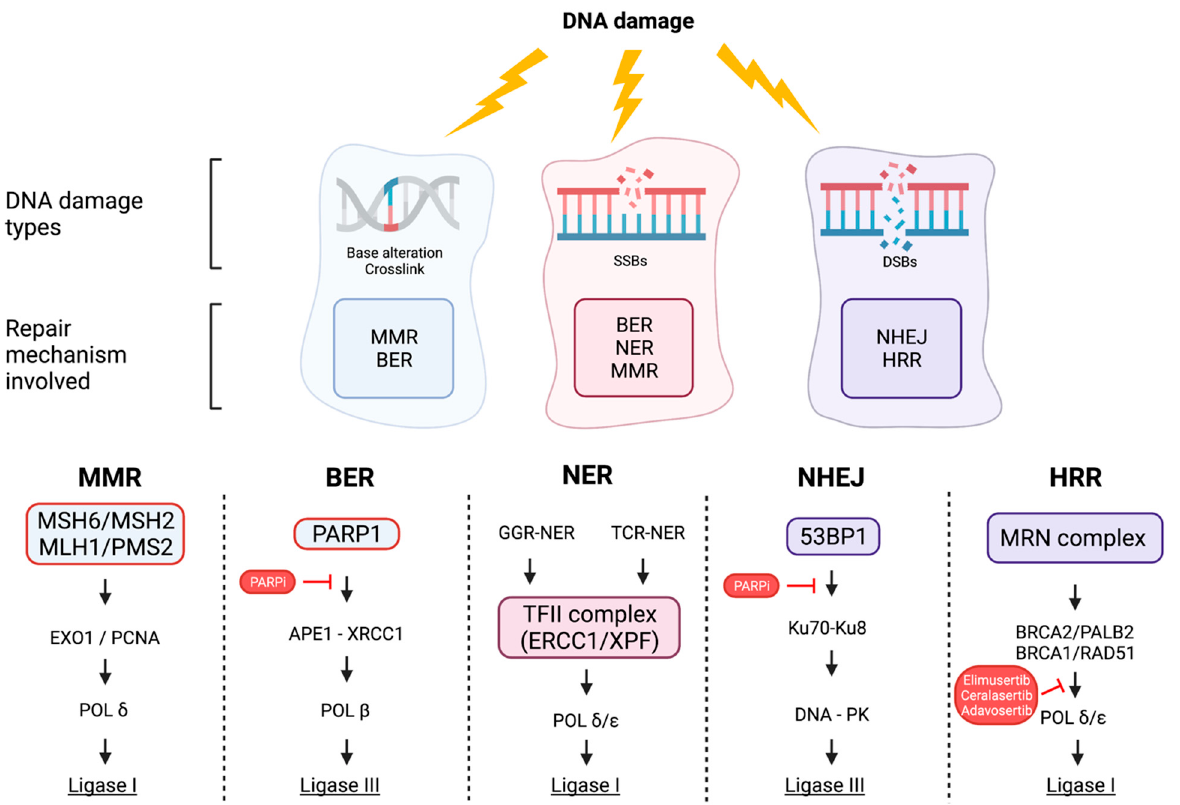
Figure 1. Different mechanisms for DNA damage response and main inhibitors. DNA damage is classified into different categories on the basis of the DNA damage type: single-strand breaks (SSBs), double-strand breaks (DSBs), base alterations, and crosslinks. DNA damage activates the DNA damage response pathway (DDR) that is composed of several downstream signaling pathways based on the DNA damage type. The MMR and BER pathways are activated by crosslinks, base alterations, and SSBs, the NER pathway is activated by by SSBs, and the NHEJ and HRR pathways are activated by DSBs. We also represented the main drugs and their inhibitor sites that are currently under investigation as new possible treatments in colorectal cancer (CRC). MMR, mismatch repair; BER, base excision repair; NER, nucleotide excision repair; NHEJ, nonhomologous end joining; HRR, homologous recombination repair; PARPi, PARP